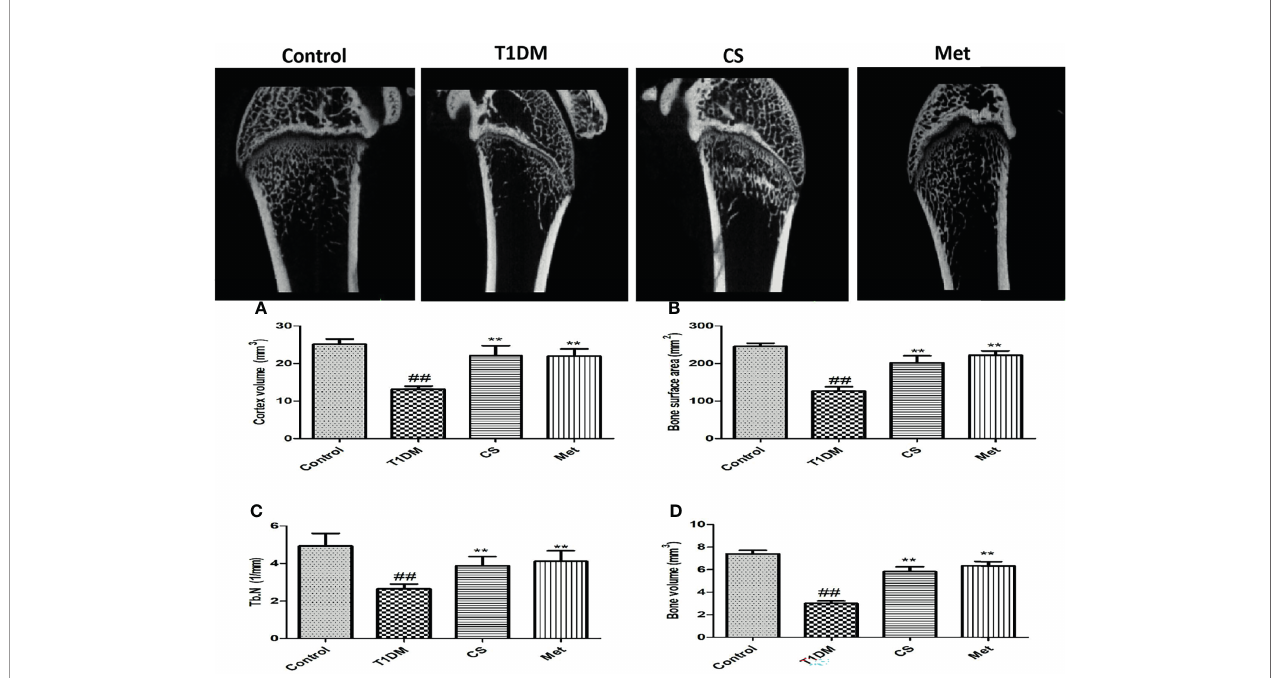
FIGURE 3 | (A) The femur micro-CT structure of different groups at the end of the 10th week. (B) Cortex volume in different groups. (C) Bone surface area in different groups. (D) Trabecular number in different groups. (E) Bone volume in different groups. ## indicates p < 0.01 compared with control. **indicates p < 0.01 compared with the diabetic